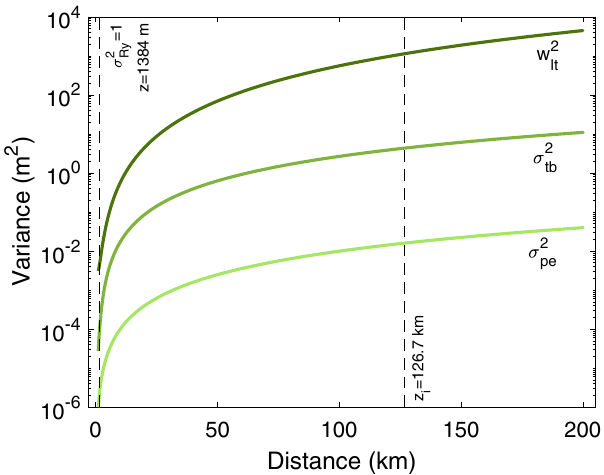
Fig. 1 Beam widening in the presence of strong turbulence. Here, we compare the variance of the centroid wandering induced by turbulence ( σ 2 , tb middle line) to that of pointing error ( σ 2 , lower line) and the long-term pe beam waist ( w 2 , upper line). We assume a collimated beam ( R 0 = + ∞ ) lt with initial radius w 0 = 5 cm and wavelength λ = 800 nm. Other parameters are the outer scale of turbulence L 0 = 1 m and index-of- refraction structure constant C 2 n ¼ 1 : 28 ´ 10 (cid:3) 14 m (cid:3) 2 = 3 (night-time ¼ 1 at z = 1384 m to operation). Rytov variance ranges from σ 2 Ry σ 2 9 : 12 ´ 10 3 at z = 200 Ry >